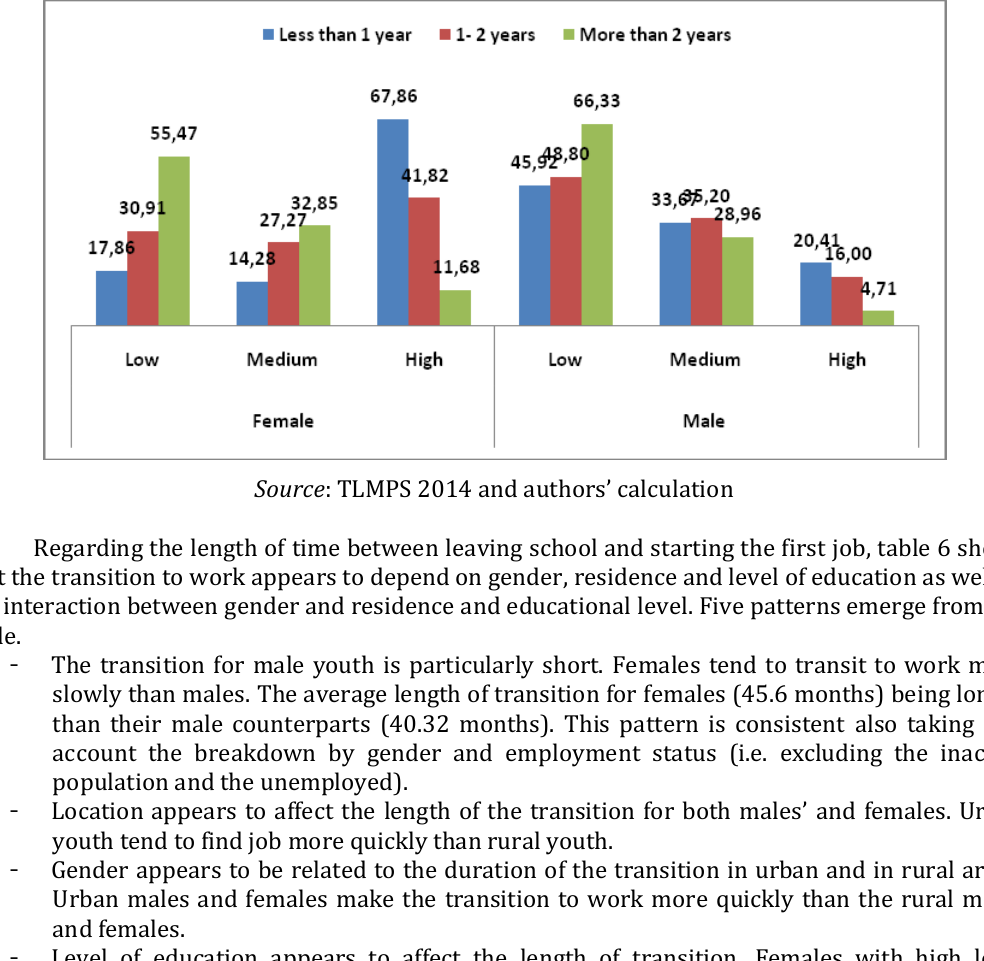
Table 6: Average lengths of transition to first job: by gender, residence area and by education status (months) Lengths of transition to first job(any job, including direct